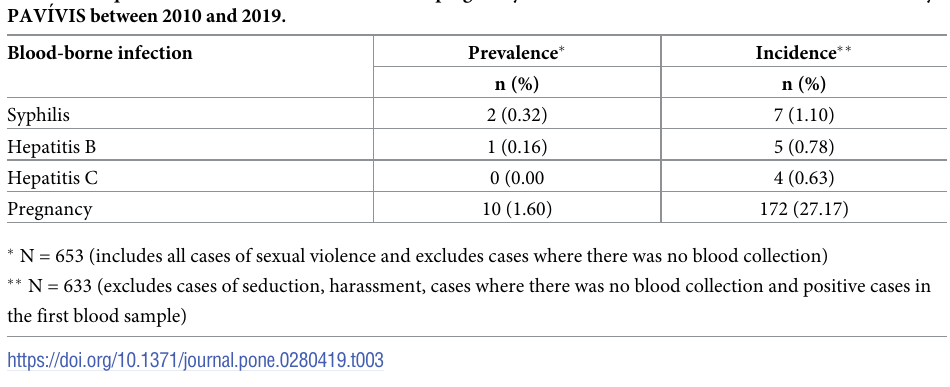
the 2nd test compared to those reporting only one sexual partner (p = 0.036). And those